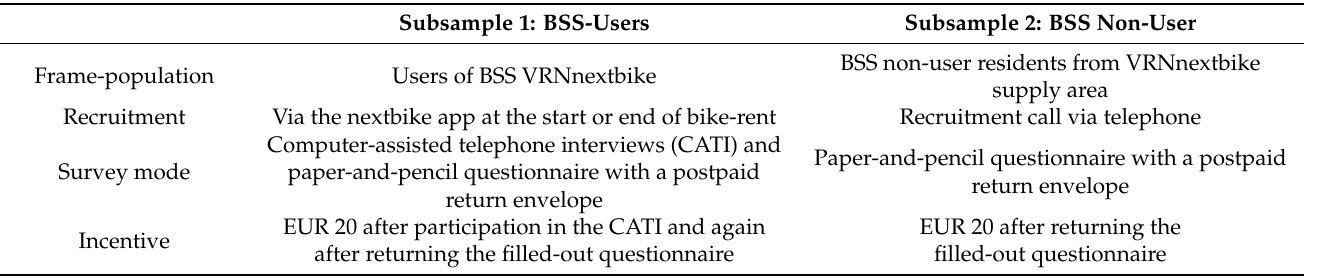
Table 1. Frame population and recruitment